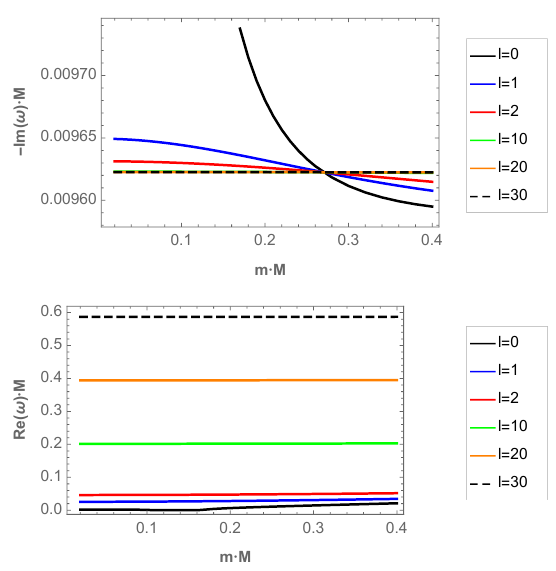
Figure 3 . The behaviour of the QNFs for the dominant photon sphere modes ( n PS = 0), Im ( ! ) M (top panel) and Re ( ! ) M (bottom panel), as a function of mM for di(cid:11)erent values of the parameters ‘ = 0 ; 1 ; 2 ; 10 ; 20 ; 30, with M 2 (cid:3) = 0 : 11.